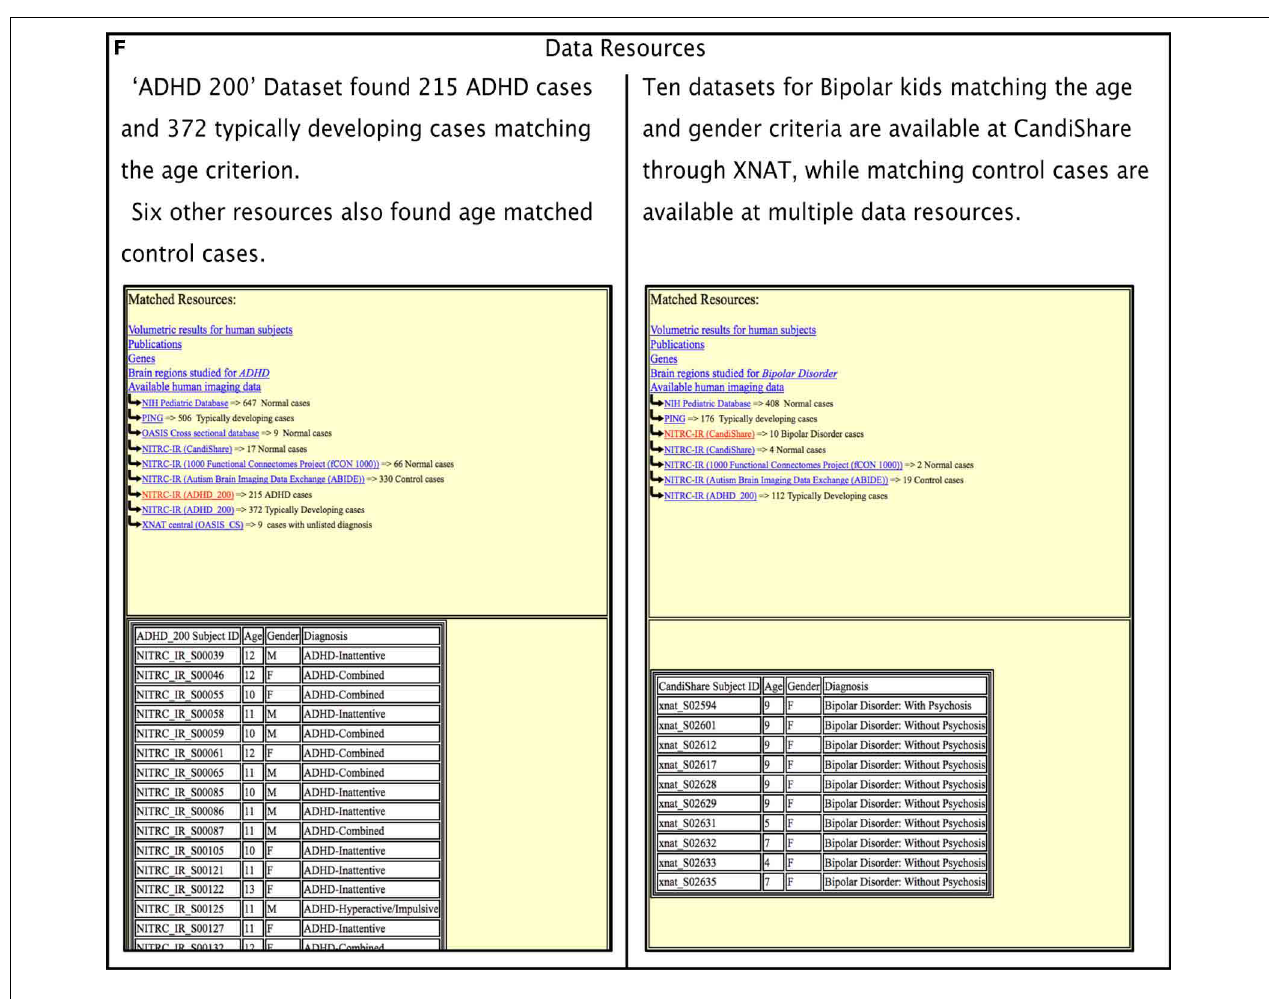
FIGURE 3 | Portal output based on two separate search criteria. (A) Search criteria, (B) Results of IBVD for each of the queries displayed in tabular as well as z-score plot form, (C) Publication results for the queries, (D) Entrez Gene result along with the top five most published genes for the